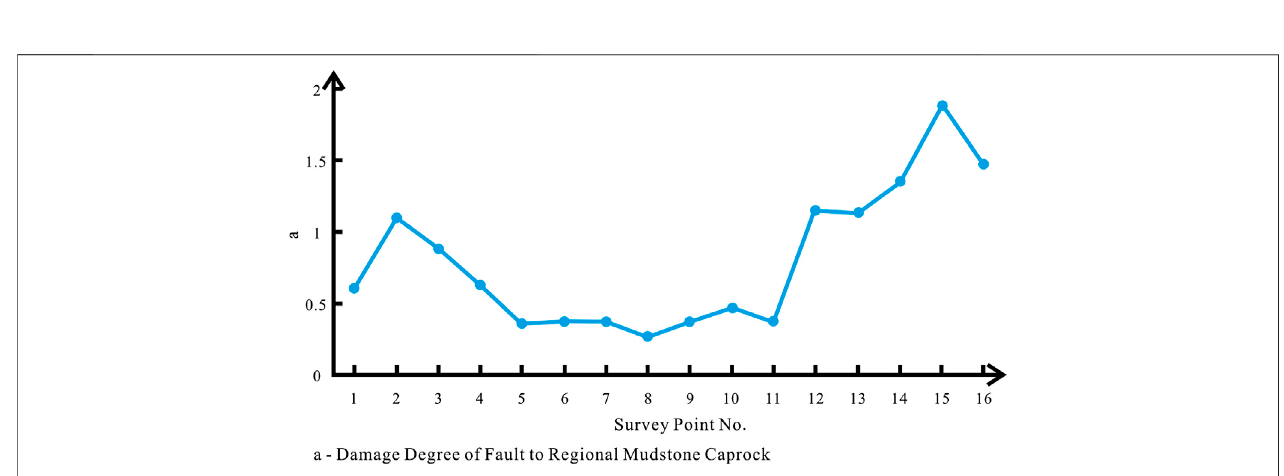
FIGURE 9 | Damage degree of the Zhangdong Fault to the regional mudstone caprock of E 3 s 1M during the hydrocarbon accumulation period.